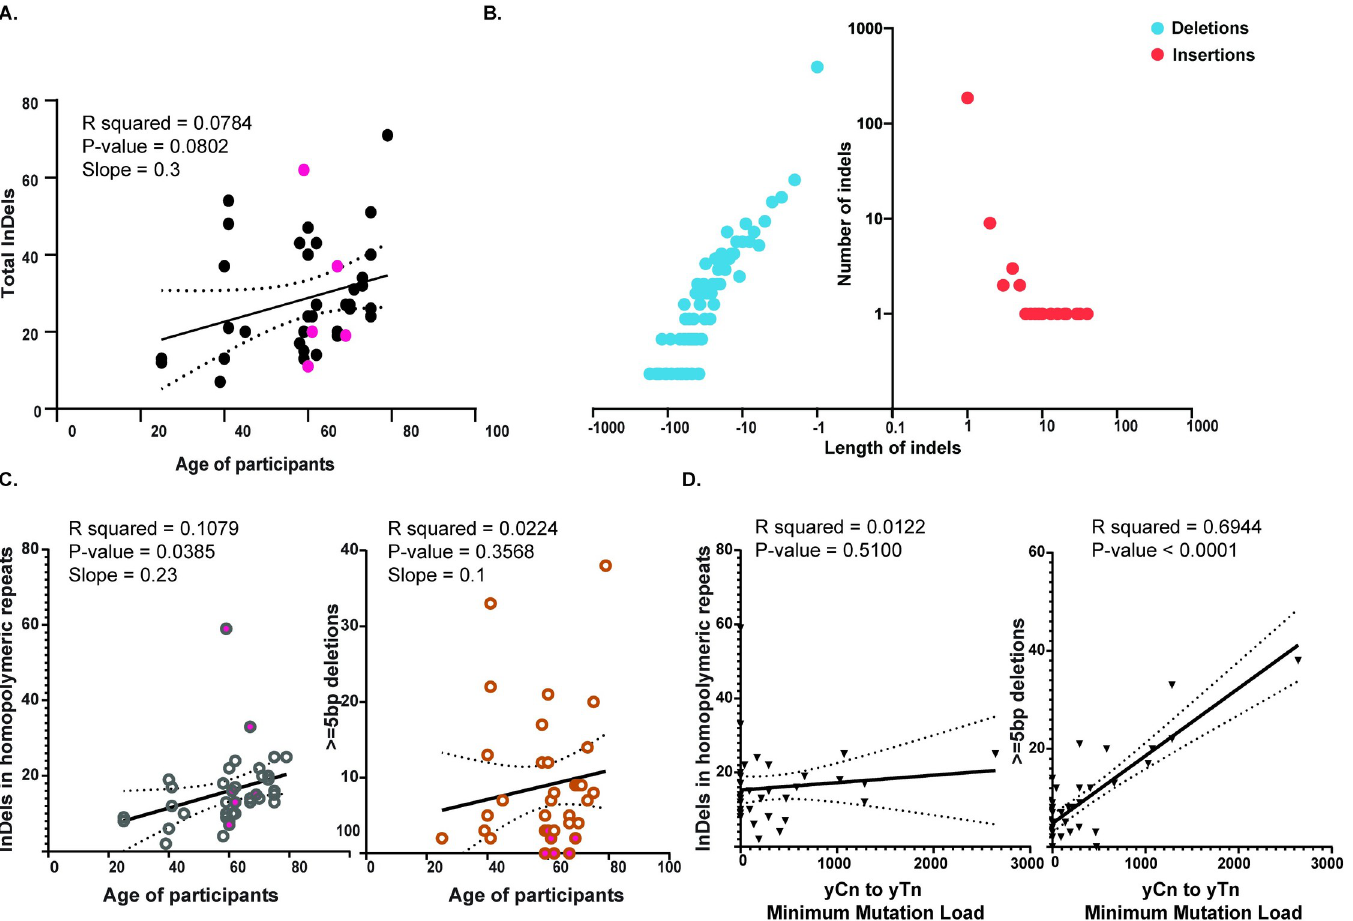
Fig 3. Analyses of indels in skin cells. (A) The total number of indels identified in each sample plotted against the ages of the donors. The black dots denote fibroblast clones, while the pink dots denote the melanocyte clones. (B) The distribution of the lengths of the insertions and deletions detected in the clonal lineages. The source data for panels A and B is in S6 Table. (C) The number of insertions and deletions in homopolymeric repeats and the deletions spanning 5 bases or more plotted against the ages of the donors. The open circles denote fibroblast clones, while the filled in circles denote melanocyte clones. The source data for this figure are in S7 Table. (D) The number of insertions and deletions in homopolymeric repeats and the deletions spanning five bases or more plotted against the yCn ➔ yTn minimum mutation load in skin cells. The source data for this panel are in S4 and S6 Tables. In the graphs, the black solid line is the linear regression of the data, and the dotted black curves are the 95% confidence